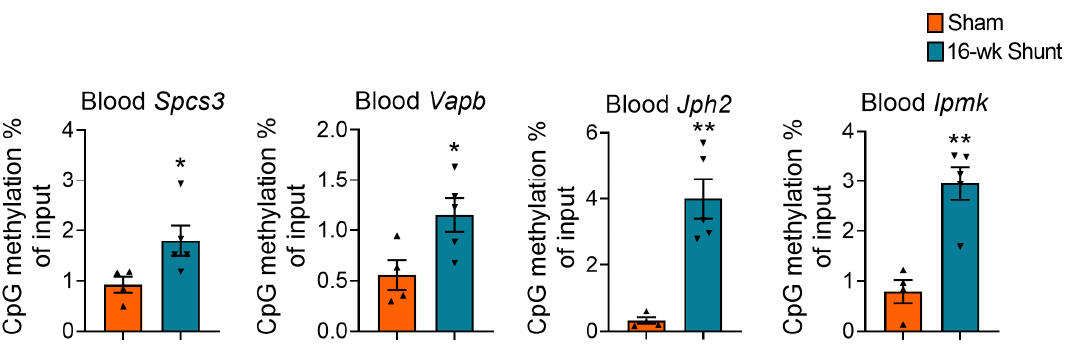
Figure 4. Promoter DNA methylation in the blood of shunt mice. MeDIP-qPCR results showing the promoter methylation level for the four selected genes from the DNA isolated from 16-week-shunt mice blood. Values are mean ± SEM, n = 4–5 mice/group. * p < 0.05, ** p < 0.01 vs. sham, two-tailed unpaired Student’s t -test.